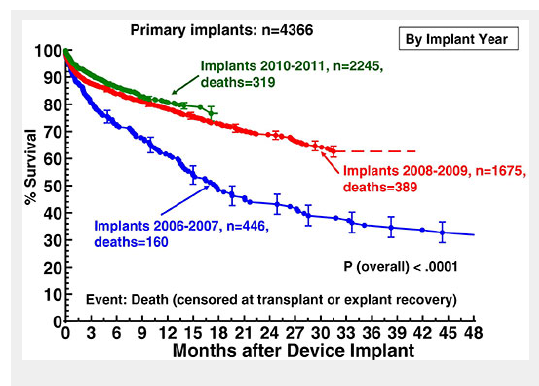
Survival rates in two trials of LVADs as destination therapy (REMATCH trial 2001, HeartMate II destination therapy trial 2009). From: Fang JC. Rise of the machines – left ventricular assist devices as permanent therapy for advanced heart failure. N Engl J Med 2009;361:2282-85. © 2009 Massachusetts Medical Society. Reprinted with kind permission.